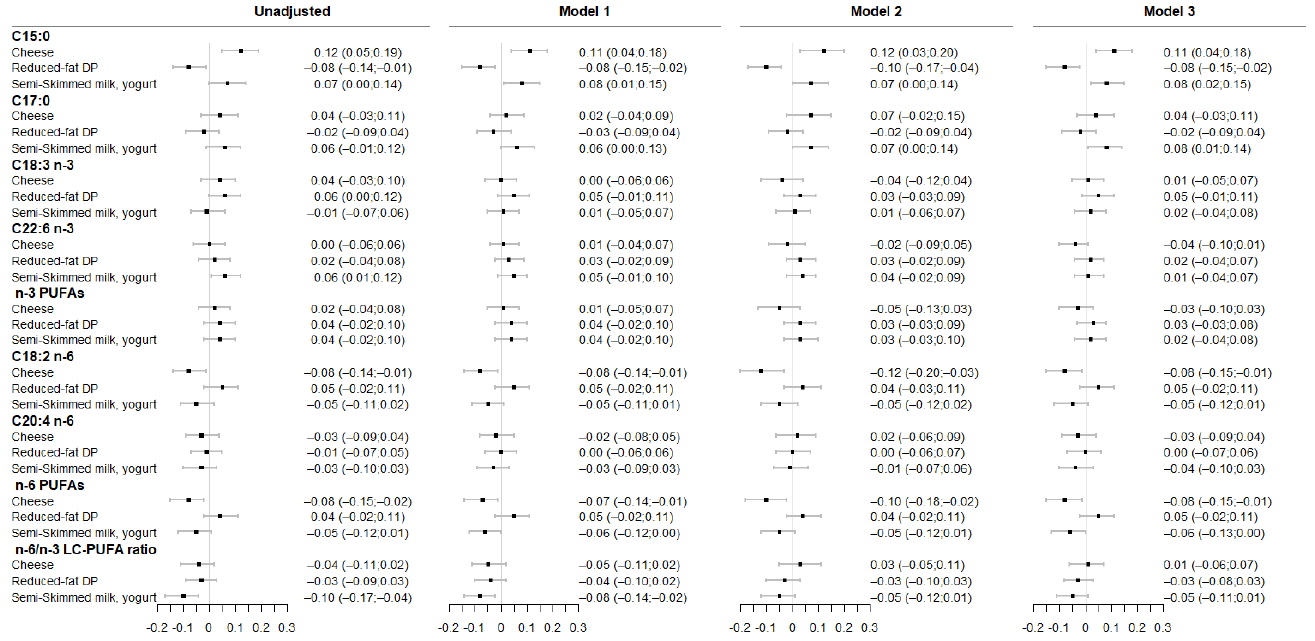
Figure 4. Associations between maternal DP patterns and fatty acid levels in colostrum. Results are from linear regression models ( β (95%CI)). Model 1 was adjusted for study center, colostrum sampling day and maternal age at delivery. Model 2 was adjusted for model 1 covariates and for maternal “healthy” dietary pattern during pregnancy. Model 3 was adjusted for model 1 covariates and for the frequency of fish consumption during pregnancy. All DP patterns were studied simultaneously within each model.